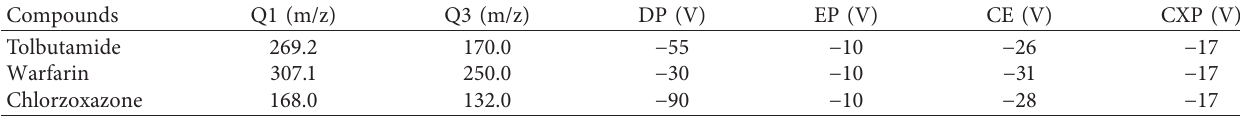
Table 2: Mass scan method parameters of tolbutamide, warfarin, and chlorzoxazone (internal standard, IS).